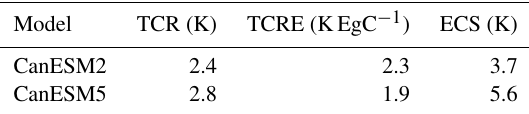
Table 3. Key sensitivity metrics: transient climate response (TCR), transient climate response to cumulative emissions (TCRE), and equilibrium climate sensitivity